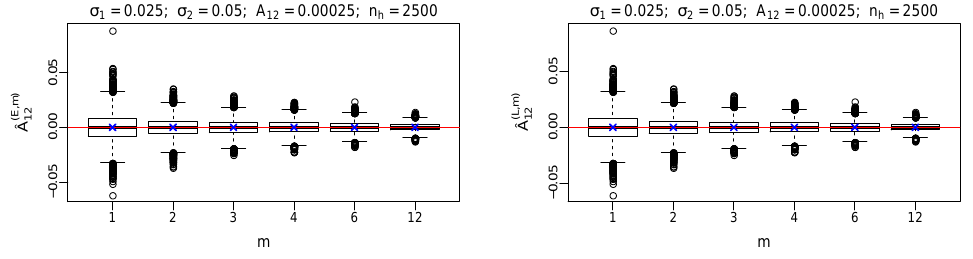
and ˆ A ( L , m ) distributions, as a function of m. The red horizontal line represent Figure 3. Boxplot of ˆ A ( E , m ) 12 12 the true value of A 12 and the blue X’s stand for the average value of ˆ A ( m )